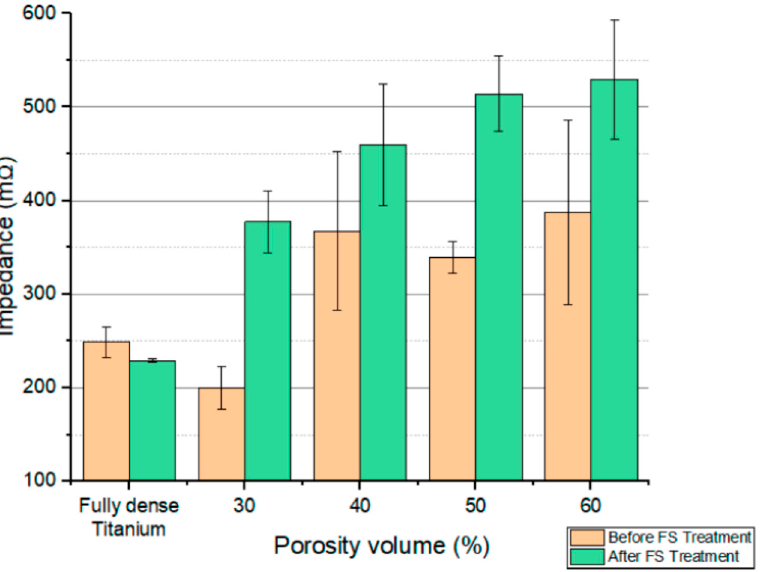
Figure 5. The change of impedance after laser modification for samples with different porosity volume [26].